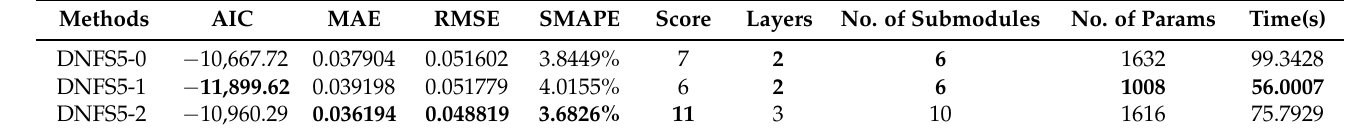
Table 5. The performance of DNFSs with different shared inputs on Test Dataset No. 1.